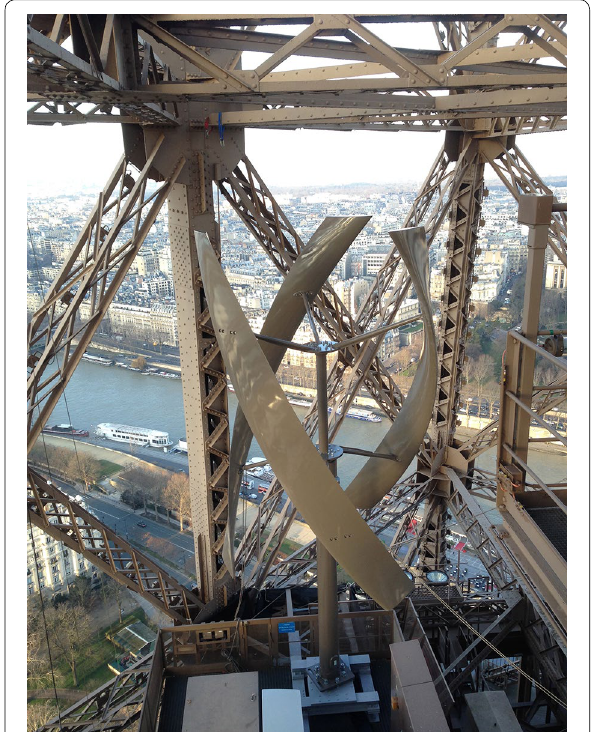
Fig. 17 Wind turbine on the Tour Eiffel, Paris (from http://www.sunwi ndene rgy.com)